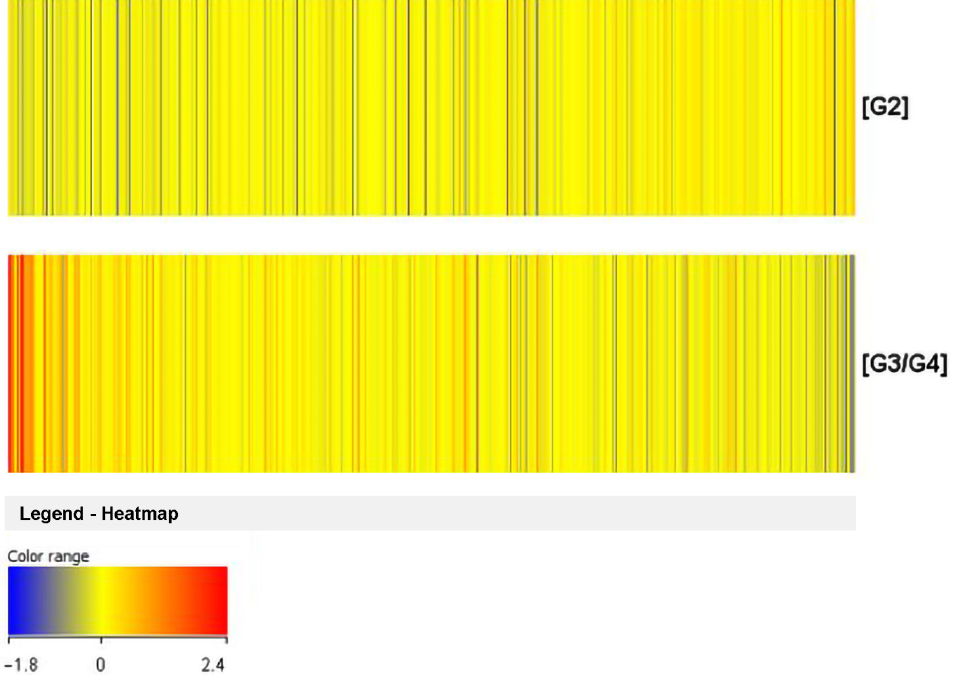
Figure 4. Graphical illustration of differences in expression profiles genes based on tumor malignancy. The color variation between transcriptome groups indicates the presence of differences in gene expression profiles depending on tumor malignancy. Red—higher signal; high gene expression; Blue—lower signal; low gene expression; G2, G3/G4—grade of tumor malignancy. A different color pattern was observed on each of the heat maps, and thus it was confirmed that in both study groups (G2 versus G3/G4) the gene expression profiles differed. To select the differential genes, we performed a t-test. After the analysis, a Volcano plot showing the differential genes of the studied groups was generated. For differentiating genes, those for which the FC parameter was greater than 2 were selected, with a statistical significance level of p < 0.05. Among the 22,283 probes present on the HG-U133A 2.0 oligonucleotide microarray, 1,402 probes were selected to distinguish between G3/G4 and G2 tumor malignancy (Table 3). Table 3. Number of probes differentiating the test groups according to statistical assumptions. Total p p < 0.05 p < 0.02